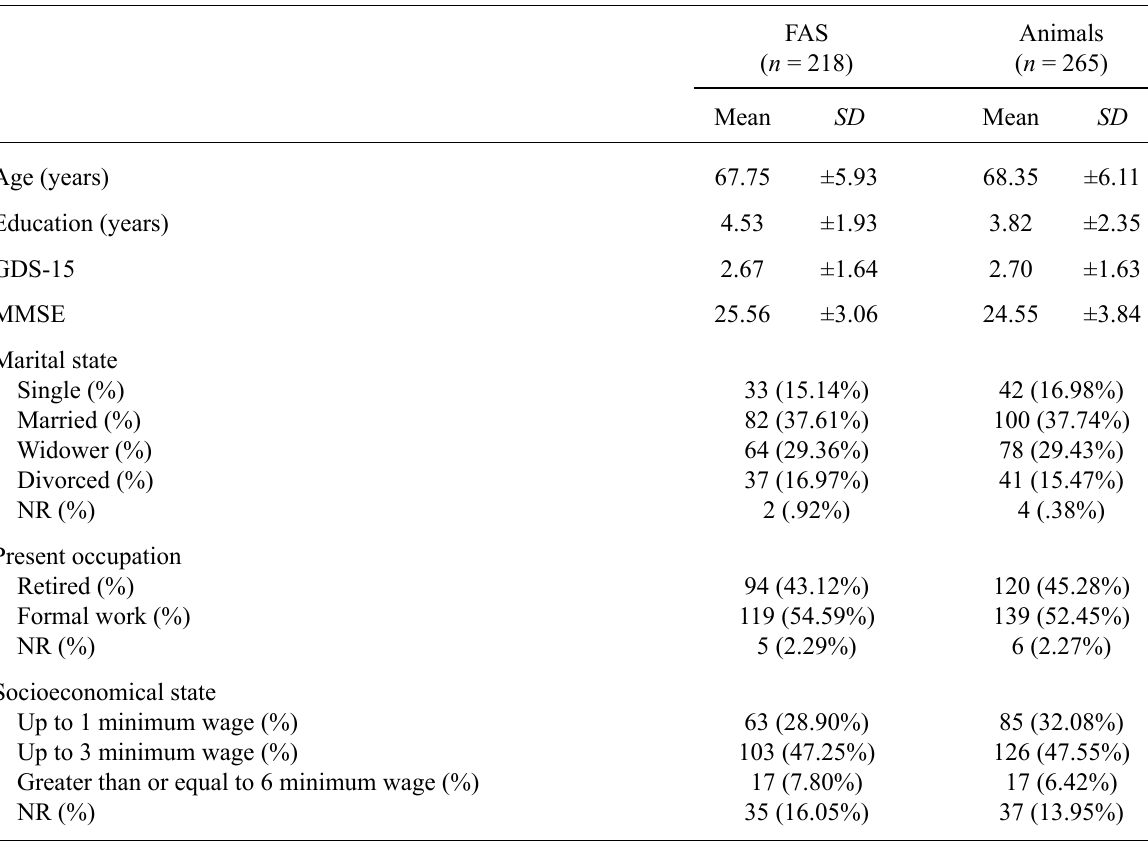
Description of Sociodemographic and Clinical Data of the Participants